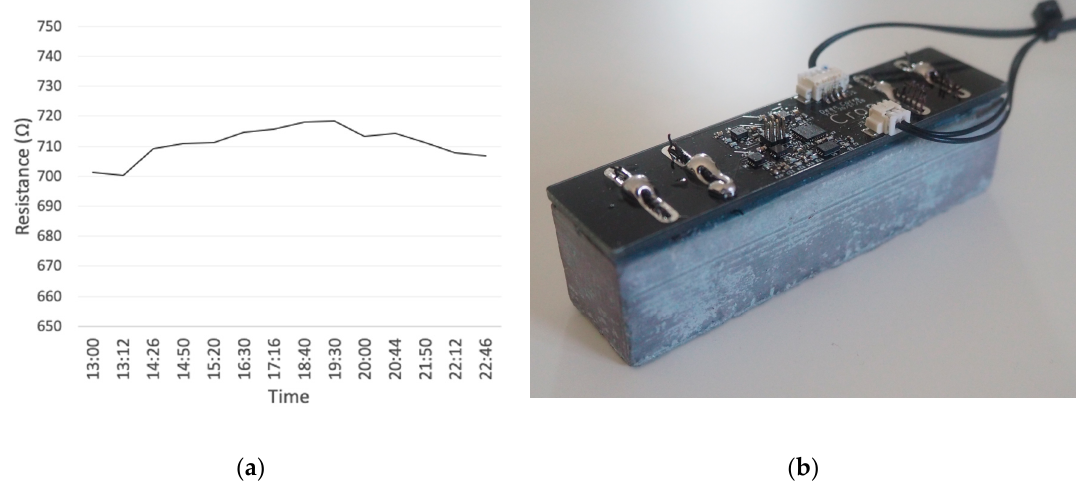
Figure 13. Sensing device mounted to sensing block, run for 10 h to show deviation: ( a ) voltage deviation over 10 h; and ( b ) sensing device setup.